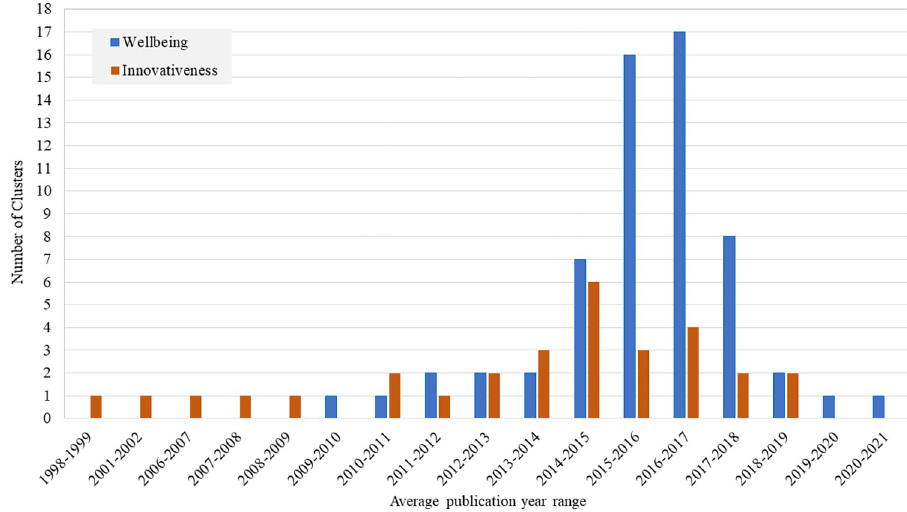
Fig 2. Average publication year range and numbers of clusters in each range for well-being and innovativeness research.